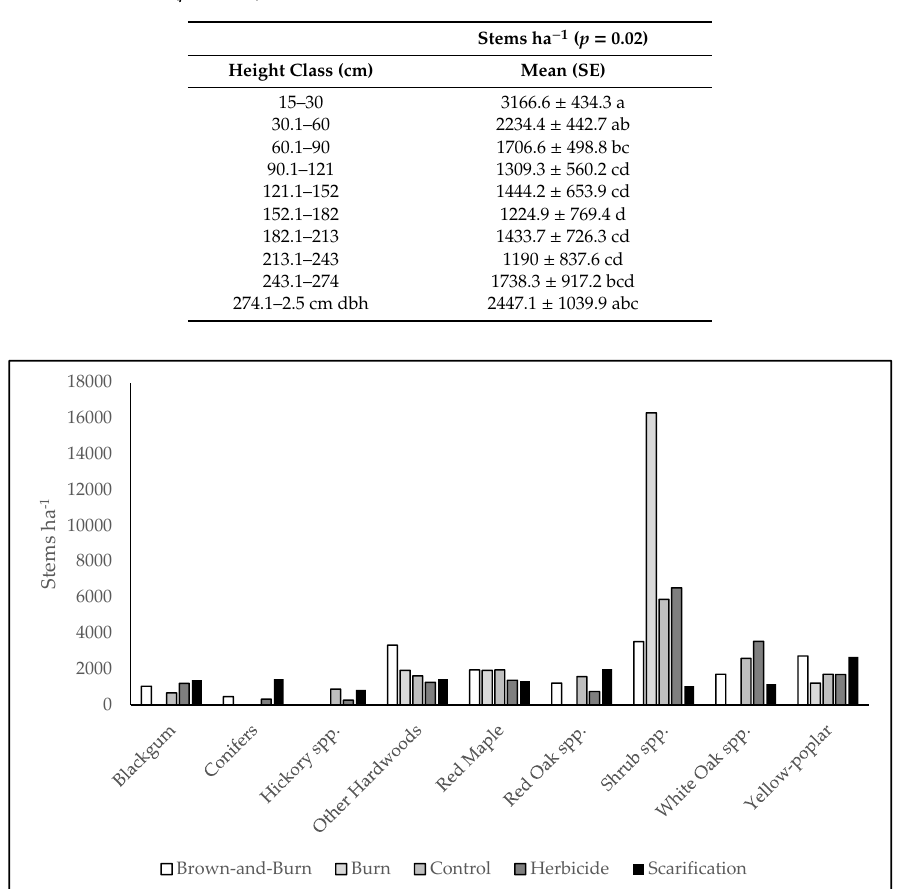
Figure 2. Regenerating woody species’ average number of stems per hectare for the treatment × species interaction ( p = 0.05) four growing seasons after study establishment for the shortleaf pine–hardwood restoration study located in Morgan County, TN,